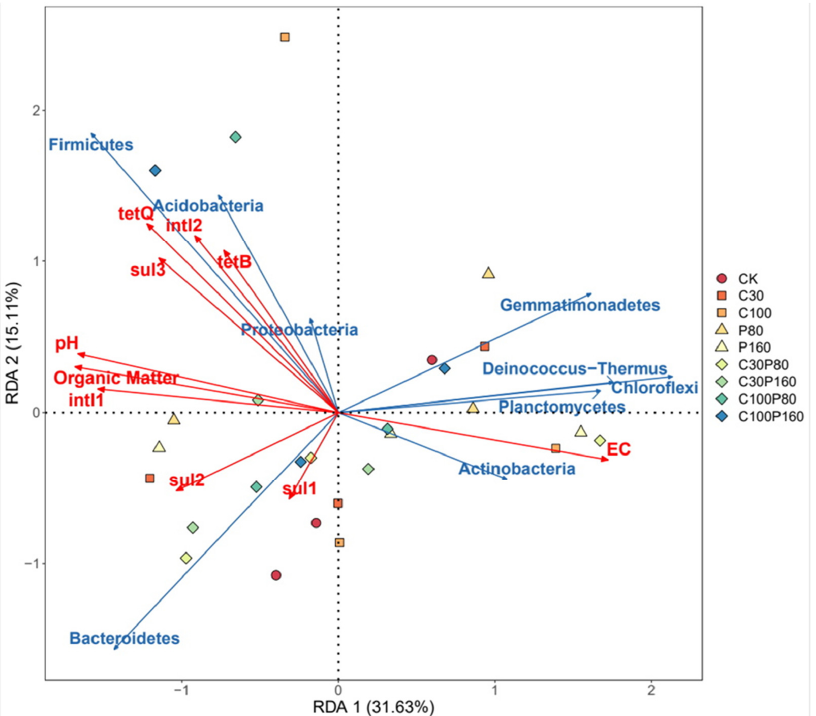
Figure 6. Redundancy analysis (RDA) shows the relationship between treatment groups, major bac- terial communities, ARGs, and MGEs. bacterial communities, ARGs, and